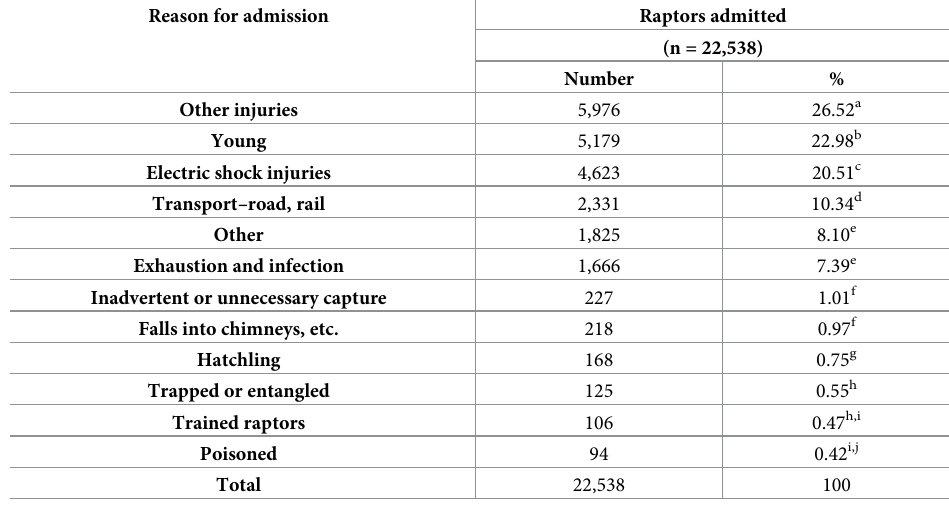
increasing trend in numbers of admitted birds during the monitored period (rSp > 0,6; p < 0.05) was found for all four most common reasons for admission (Fig 2). Considering the most frequently admitted raptor species, differences (p < 0.05) were found among the most common reasons for their admission (Table 5). Whereas common kestrels were most often admitted as young, common buzzards, Eurasian sparrowhawks, northern gos- hawk, and marsh harriers were most frequently admitted due to other injuries. Table 4. Number and percentage of raptors admitted to rescue centres in the Czech Republic according to the rea- sons for their admission. Reason for